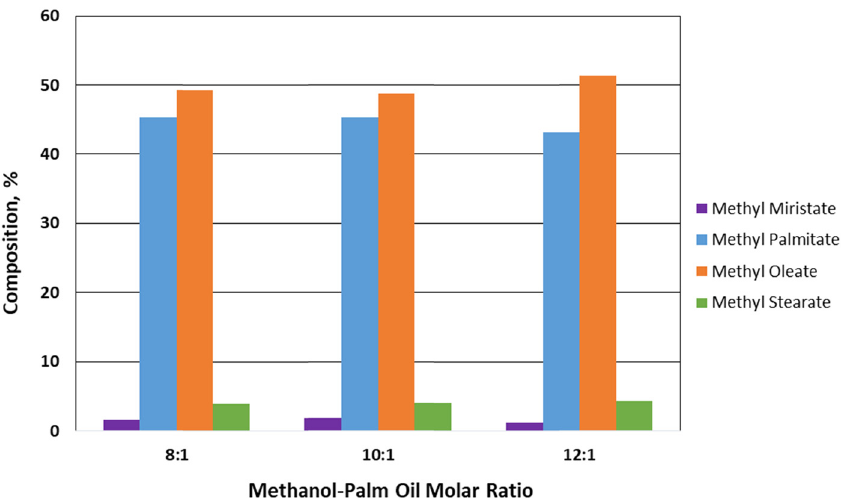
Figure 4: Major FAME composition for various methanol – palm oil molar ratios.